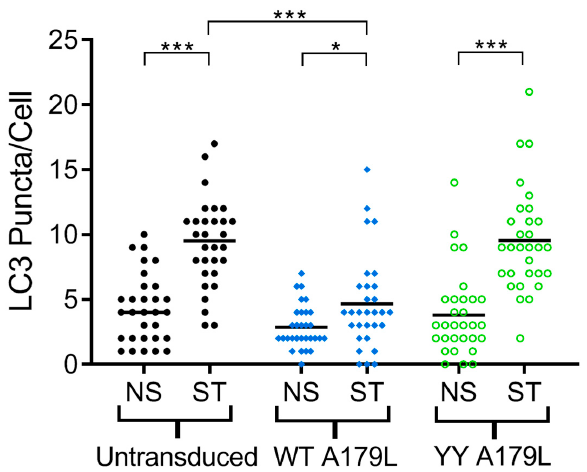
Figure 6. A179L-mediated inhibition of autophagosome formation. The number of LC3 puncta per cell for 30 individual cells per indicated experimental condition was quantified by Imaris analysis of confocal images. Vero cells were transduced with AdH5 vectors encoding either wildtype A179L or A179L V73Y / G89Y, or left untransduced and were incubated for a total of 24 h. Prior to fixation, cells were either incubated in complete cell media (NS) or starved in EBSS (ST) for 3 h to induce autophagy. Centre lines show the medians and asterisks represent significant di ff erences between the values (* p < 0.05, *** p <